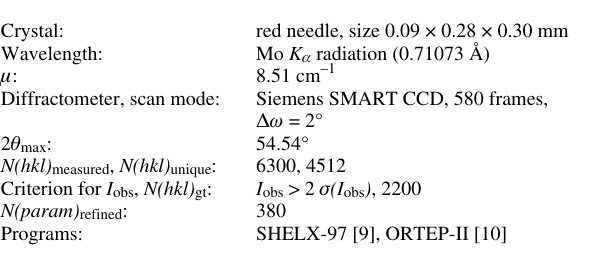
Table 1. Data collection and